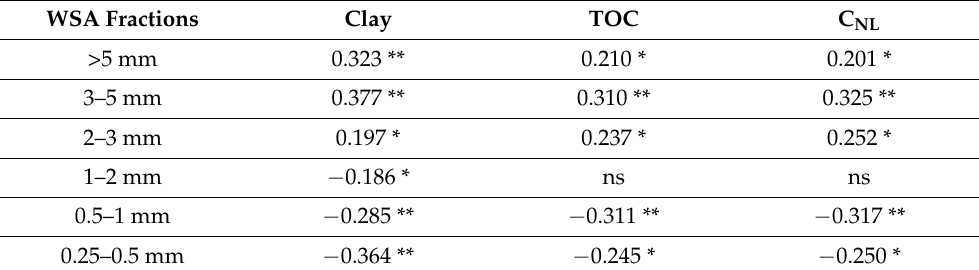
Table 4. Correlations between the clay and organic carbon contents and the fractions of water-resistant macroaggregates. WSA Fractions Clay TOC C NL >5 mm 0.323 ** 0.210 * 0.201 * 3–5 mm 0.377 ** 0.310 ** 0.325 ** 2–3 mm 0.197 * 0.237 * 0.252 *